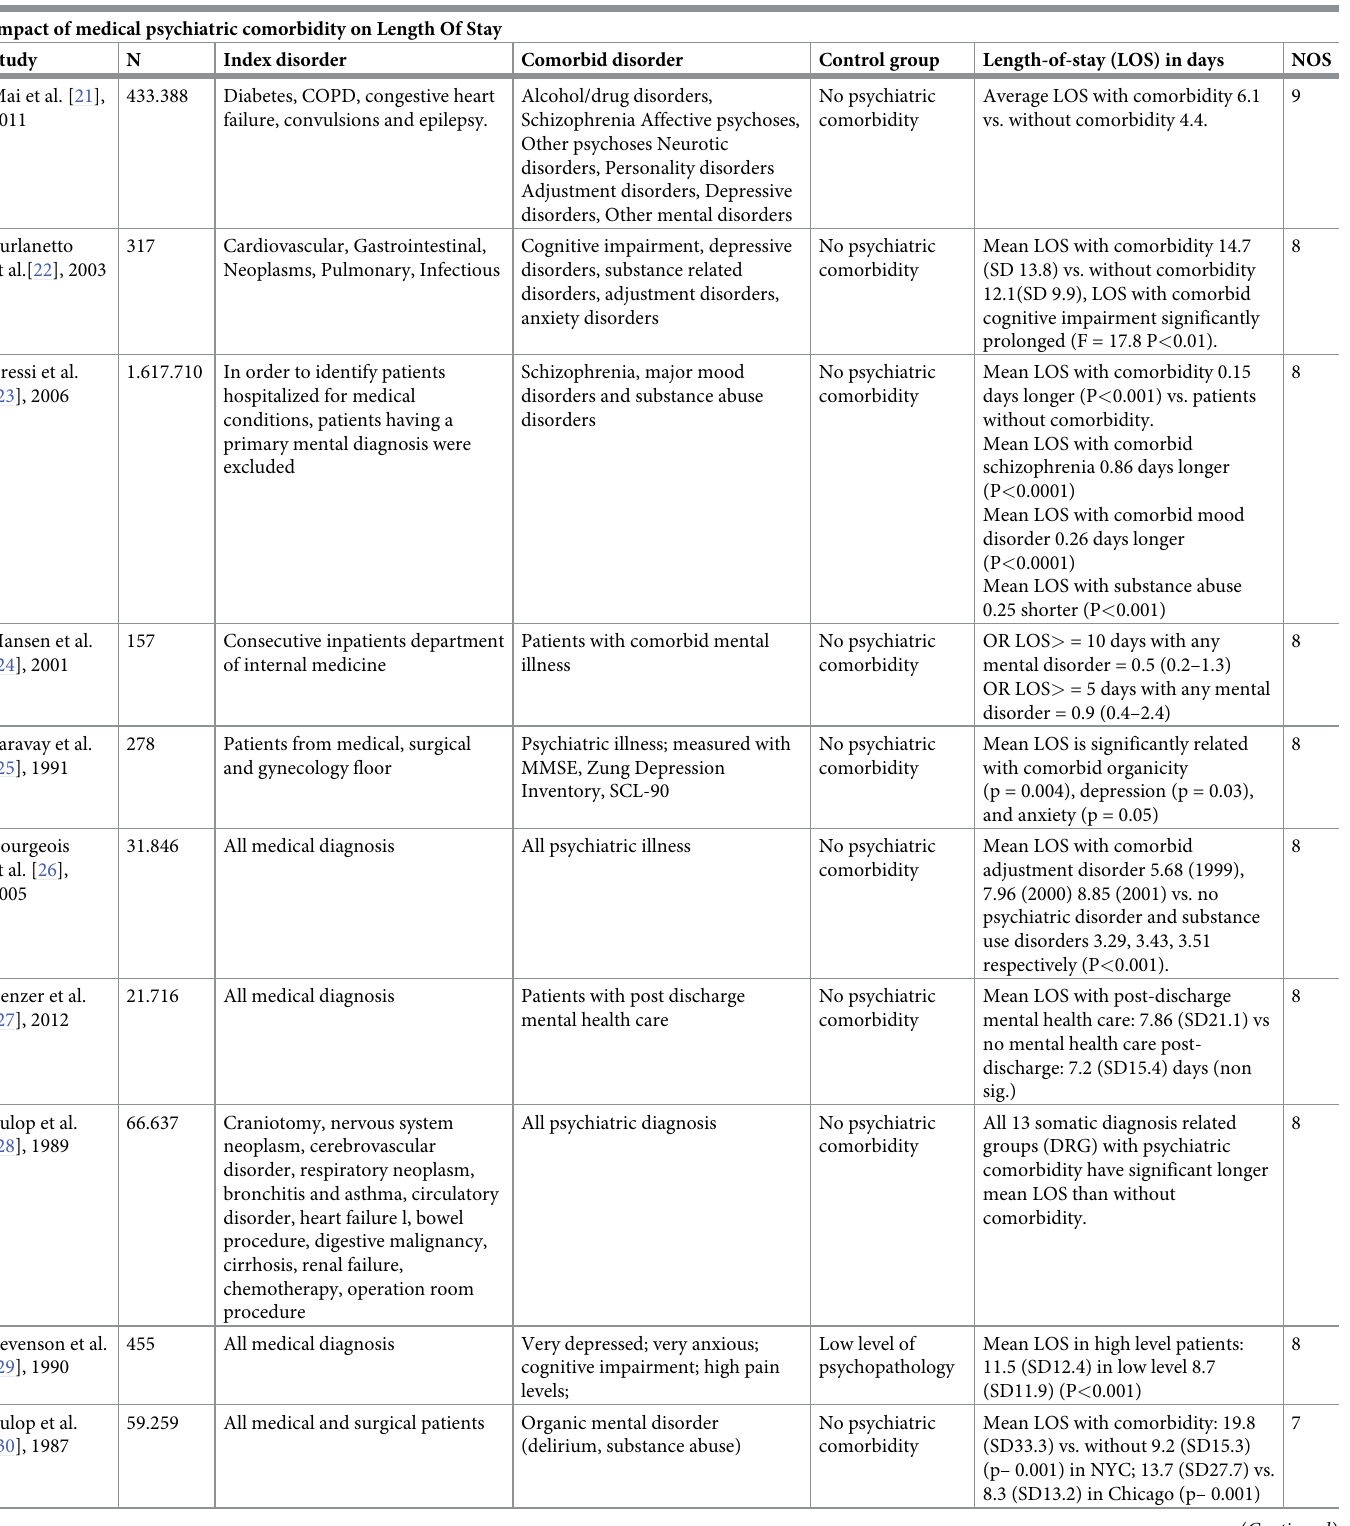
Table 3. Impact of medical-psychiatric comorbidity on length of stay (LOS), medical cost and rehospitalization. Impact of medical psychiatric comorbidity on Length Of